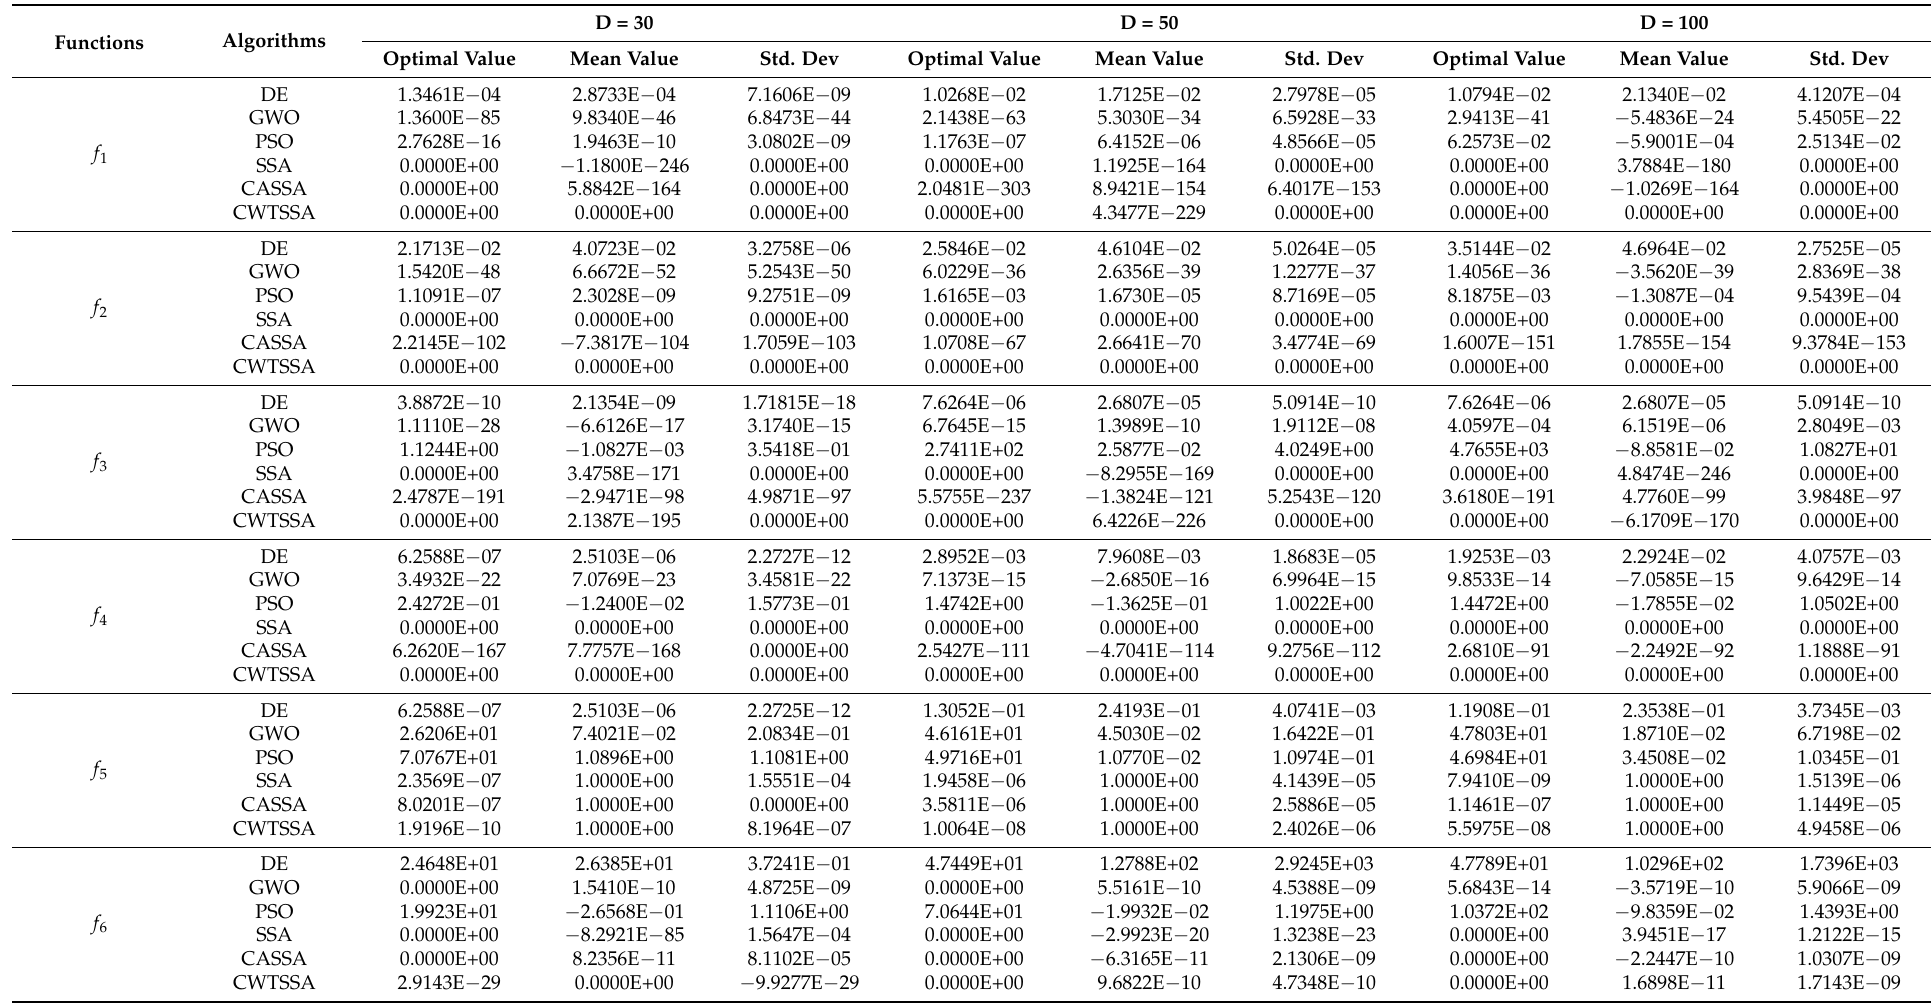
Table 4. The comparison results of five algorithms under D = 30, 50 and